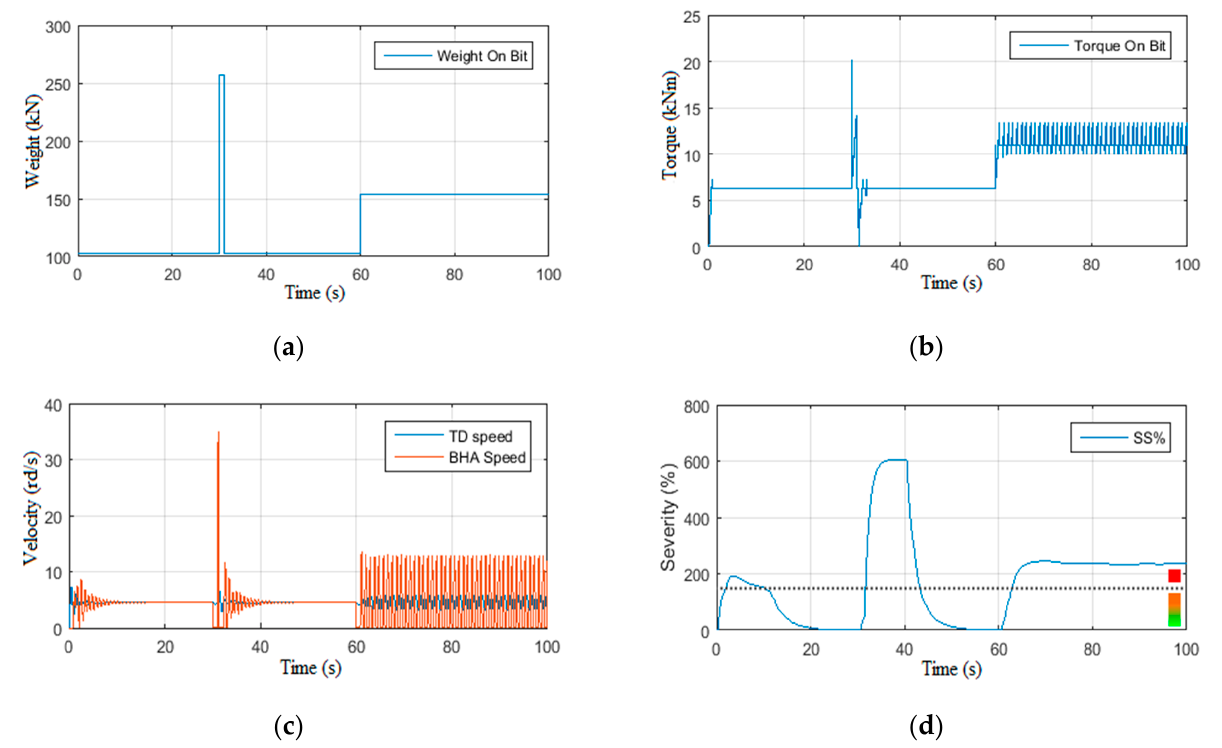
Figure 8. Scenario 2.1 responses: ( a ) Weight on bit, ( b ) Torque on bit, ( c ) Rotational velocities, ( d ) Stick-Slip severity.